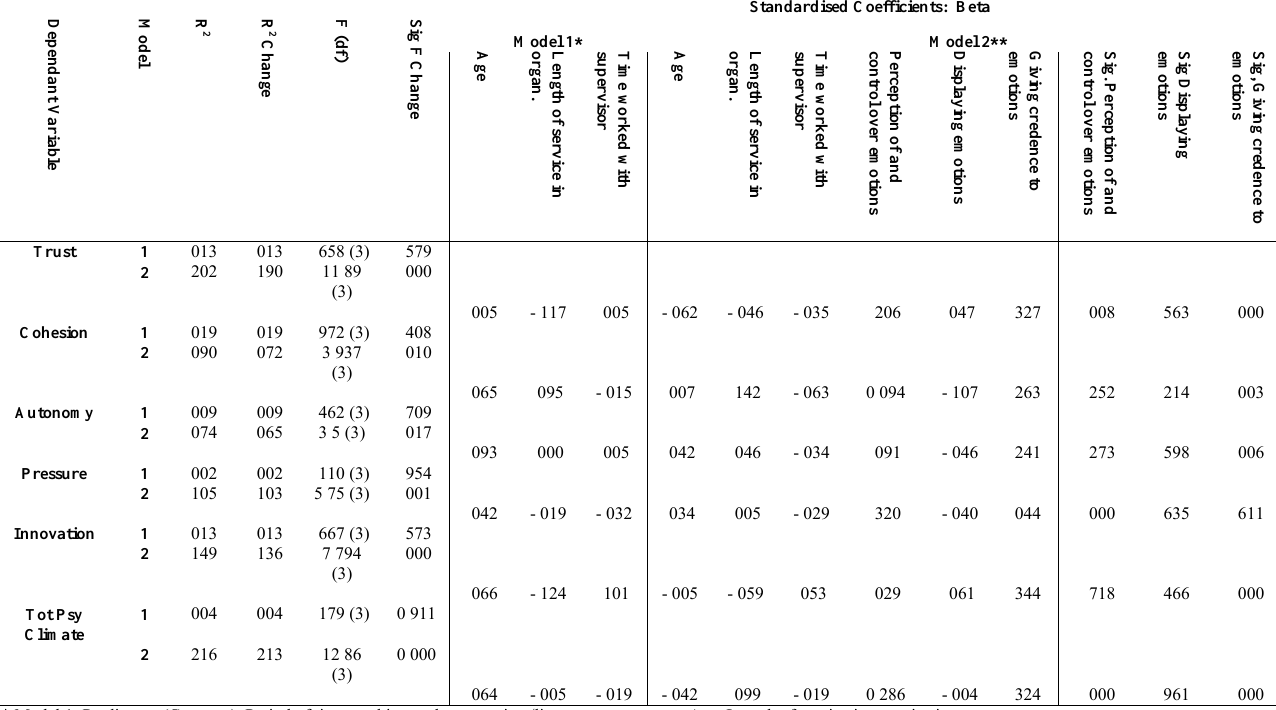
Standardised Coefficients: Beta